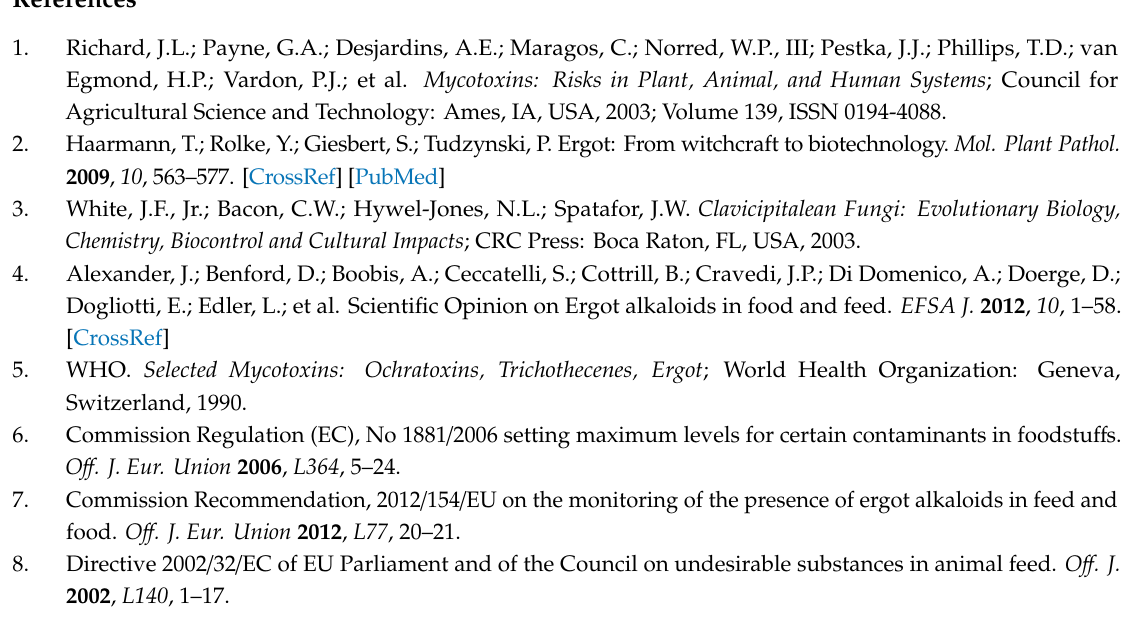
Table S1: Performance characteristics obtained during method verification for the selected